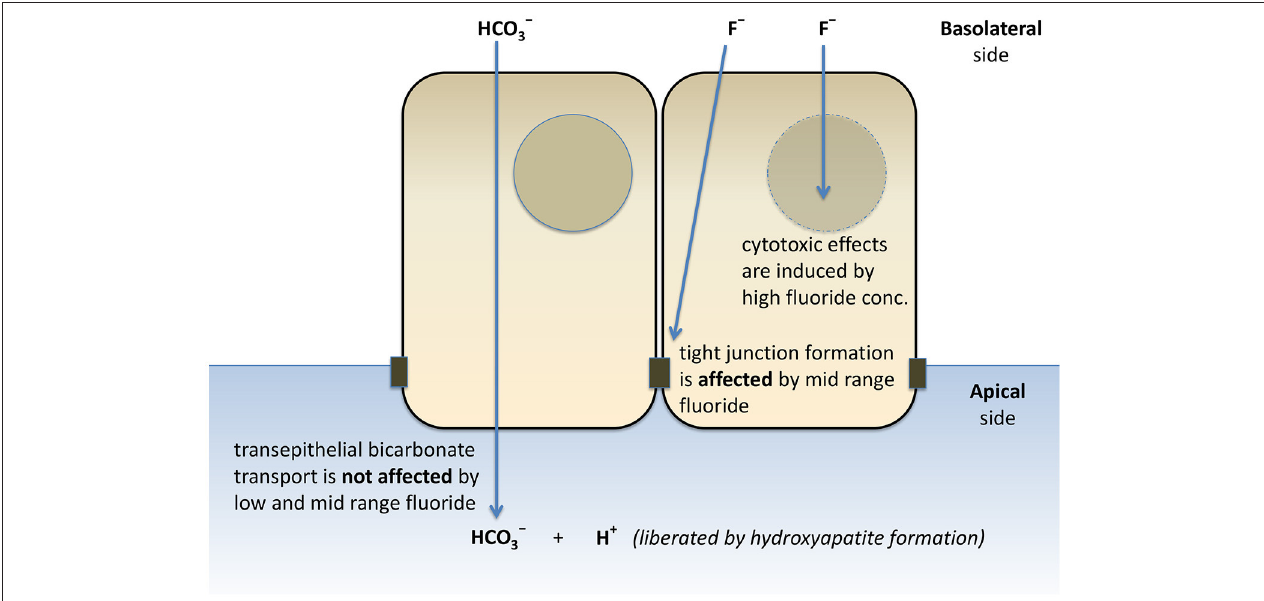
FIGURE 7 | Schematic representation of the effects of fluoride on HCO − 3 secretion, tight junction formation, and cell death of HAT-7 cells . Bilateral exposure of 2D monolayers of HAT-7 cells differentiated on Transwell membranes to low-range (0–50 µ M), mid-range (100–1,000 µ M) fluoride and high fluoride concentration (3mM) resulted in differential changes in ameloblast